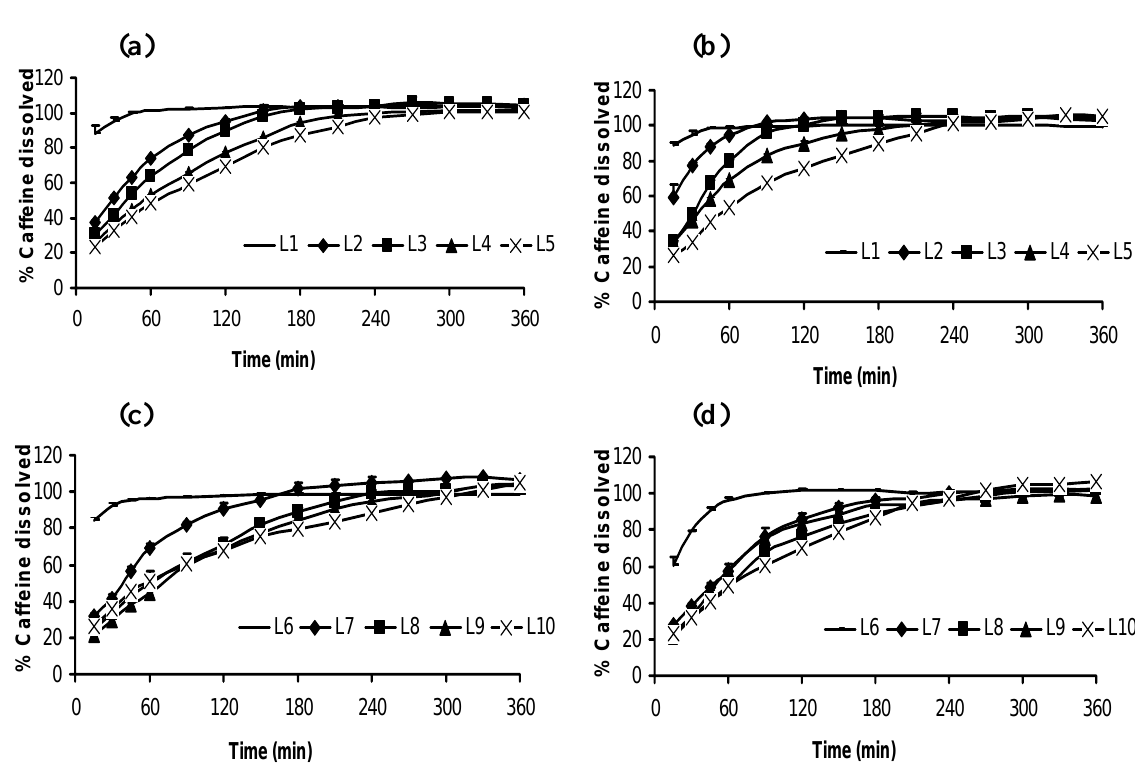
Figure 6. Dissolution profiles of CAF freeze-dried systems in demineralized water (a and c) and in progressive pH medium (1.5 → 4 → 6.8) (b and d).